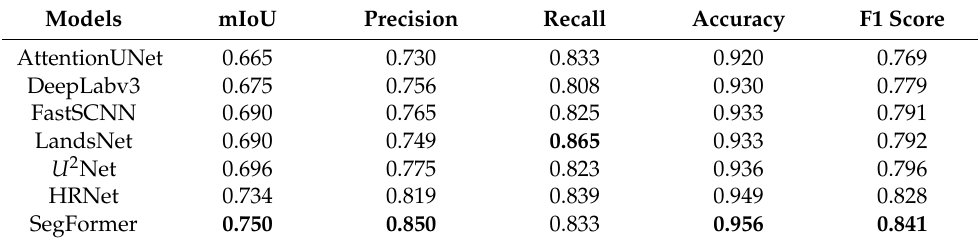
Table 1. Comparison of the average segmentation accuracy.